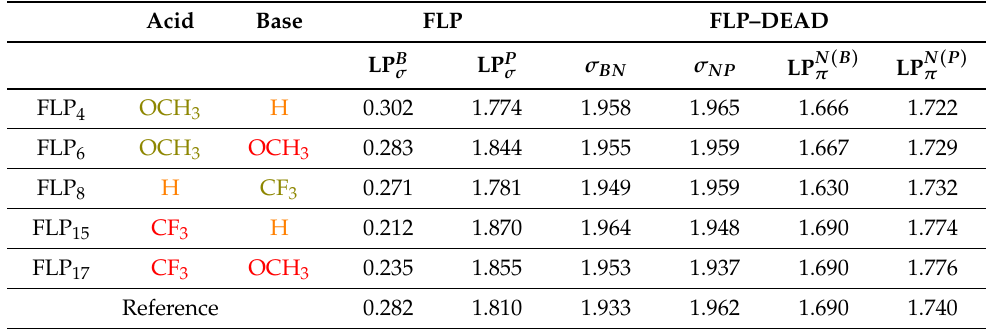
Table 3. Orbital occupancies of empty boron (LP B σ ) and phosphorous lone-pair (LP P σ ) orbitals of the FLPs. In addition, occupancies of selected bonding orbitals of the FLP–DEAD complexes ( σ B − N and